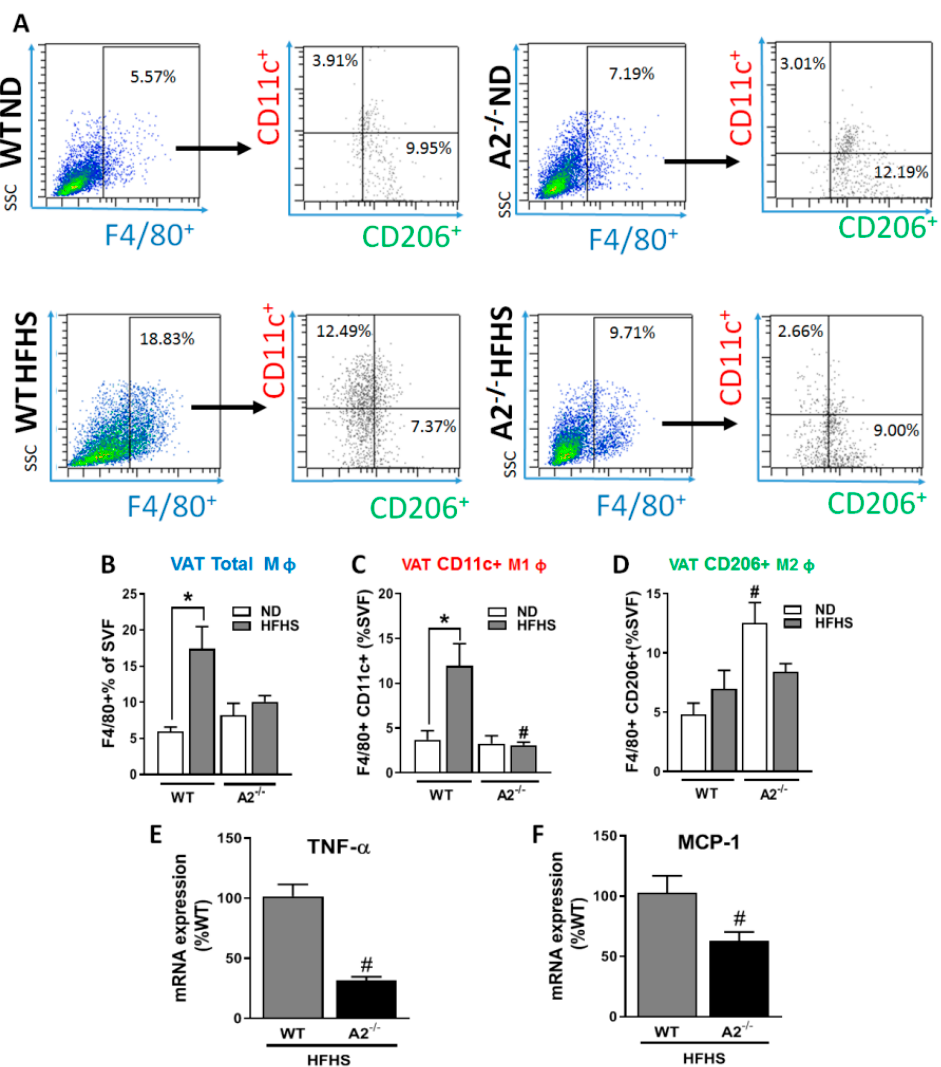
Figure 4. A2 deletion limits HFHS-induced increase in pro-inflammatory macrophages. Flow cytometry dot plots show F4/80 + SVF cells gated using PE channel against side scatter (SSC), subsets of F4/80 + cells were identified based on surface expression of CD11c and CD206 from WT and A2 − / − using unstained cells as negative control ( A ). Quantification of the plots shows the effect of A2 deletion on the percentage of F4/80 + cells ( B ), (F4/80 + CD11c + ) ( C ), and (F4/80 + CD206 + ) ( D ) of SVF, representing total macrophage, pro-inflammatory M1-like and anti-inflammatory M2-like macrophages, respectively. Values are means ± SEM; n = 5–6 mice/group. Adipocyte mRNA expression of TNF- α ( E ) and MCP-1 ( F ), n = 4 mice/group. * P < 0.05 when compared to ND-fed mice within the same genotype, # P < 0.05 when compared to WT on the same diet.